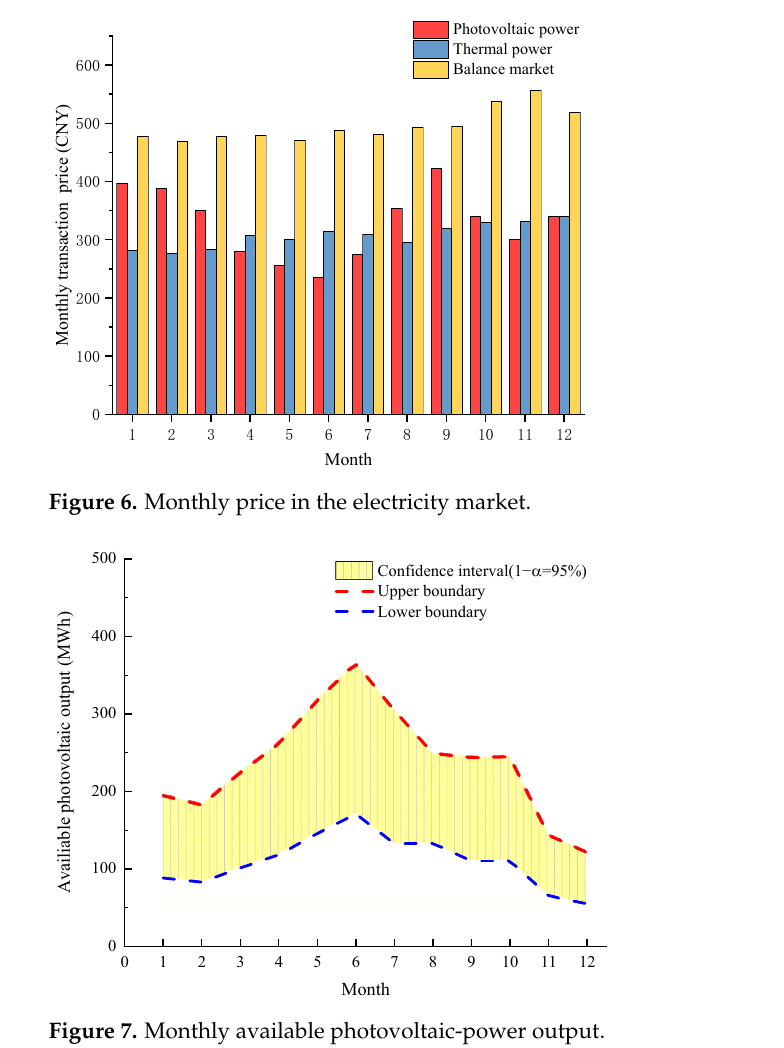
Figure 5. Monthly available thermal-power output.